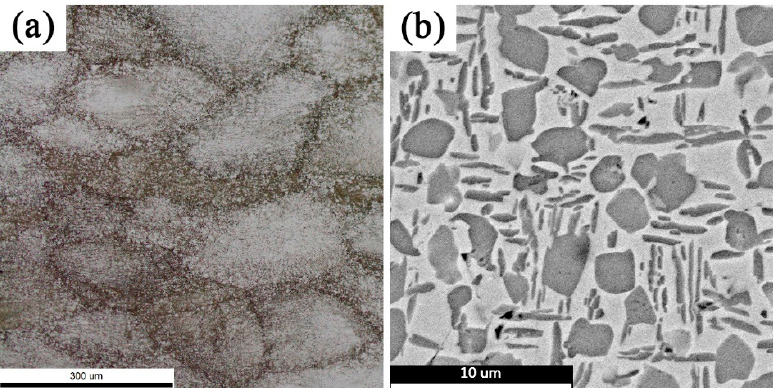
Figure 1. ( a ) Metallographic image and ( b ) SEM image of the original microstructure of Ti-55511. Samples of Φ 10 × 15 mm sizes were line-cut from an ingot and then mechanically polished. Thermal compression was conducted on a Gleeble 3800 thermo-mechanical simulator (Data sciences international, INC, New Brighton, MN, USA) at a strain rate of 0.1 s − 1 , including three stages as shown in Figure 2: (1) compression to a true strain of 0.36 at 700–850 ◦ C, followed by water quenching (Stage-D1); (2) heating to 950 ◦ C and holding for 3 min (Stage-H); (3) continuing to compress at a true strain of 0.56 and then water quenching (Stage-D2). During compression, tantalum wafers, which play the role of a lubricant, were placed between the samples and die to maintain uniform deformation. Thermocouples were welded to samples to measure the processing temperatures.